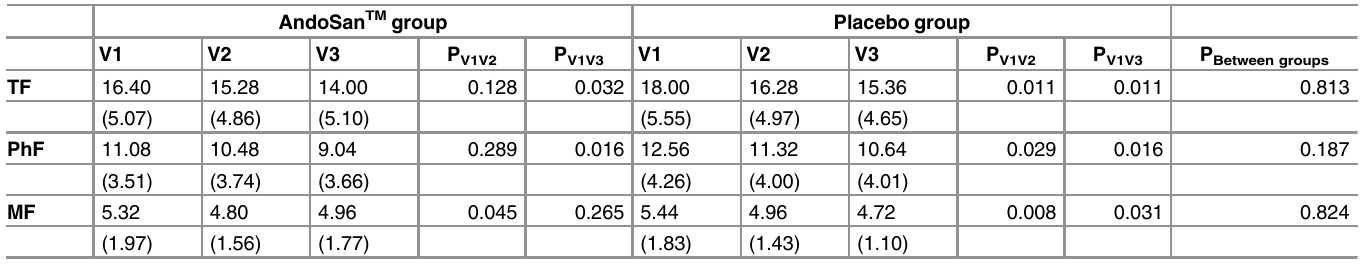
Table 4. Fatigue scores for the patients with (n = 25 AndoSan TM and n = 25 placebo) CD. AndoSan TM group Placebo